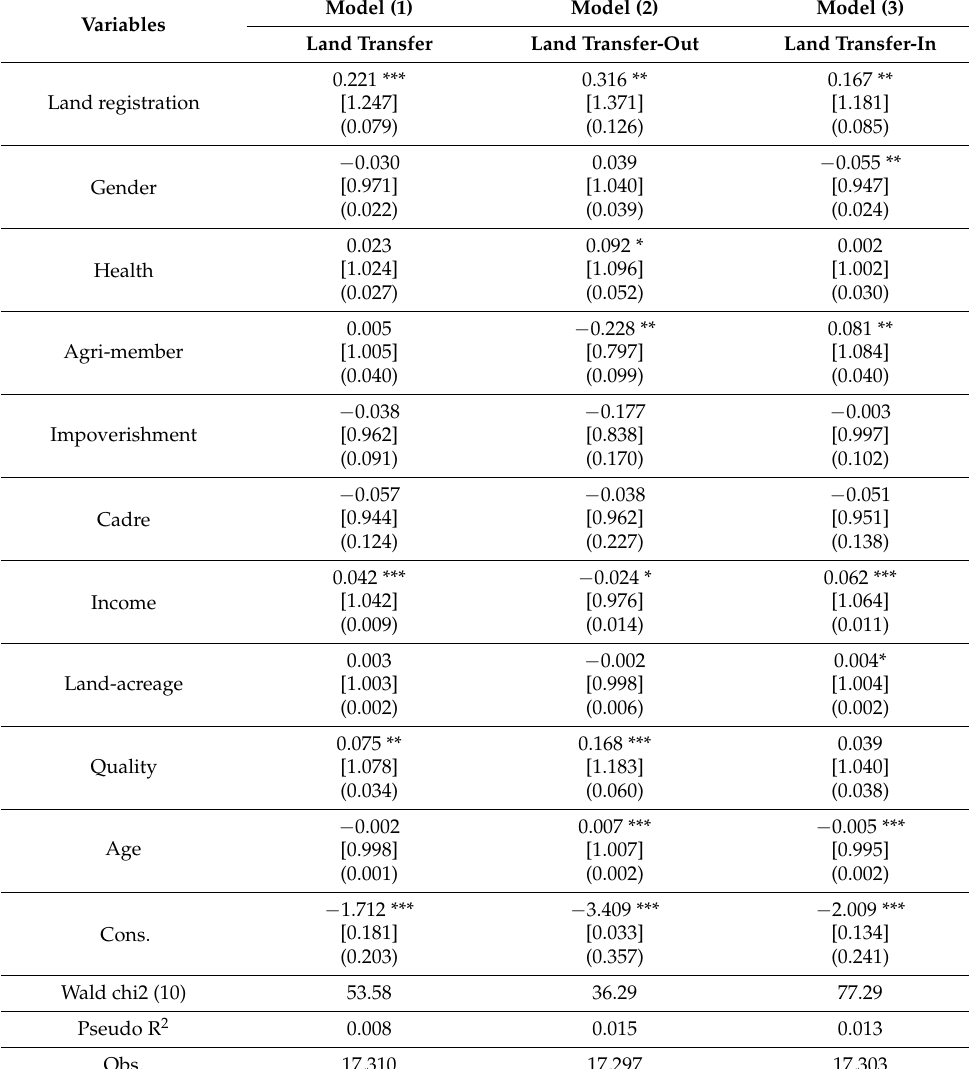
Figure 6. The relationship between households’ land registration and land transfer in rural China. Table 4. Estimation results of the Logit model of the impacts of the land registration program on land